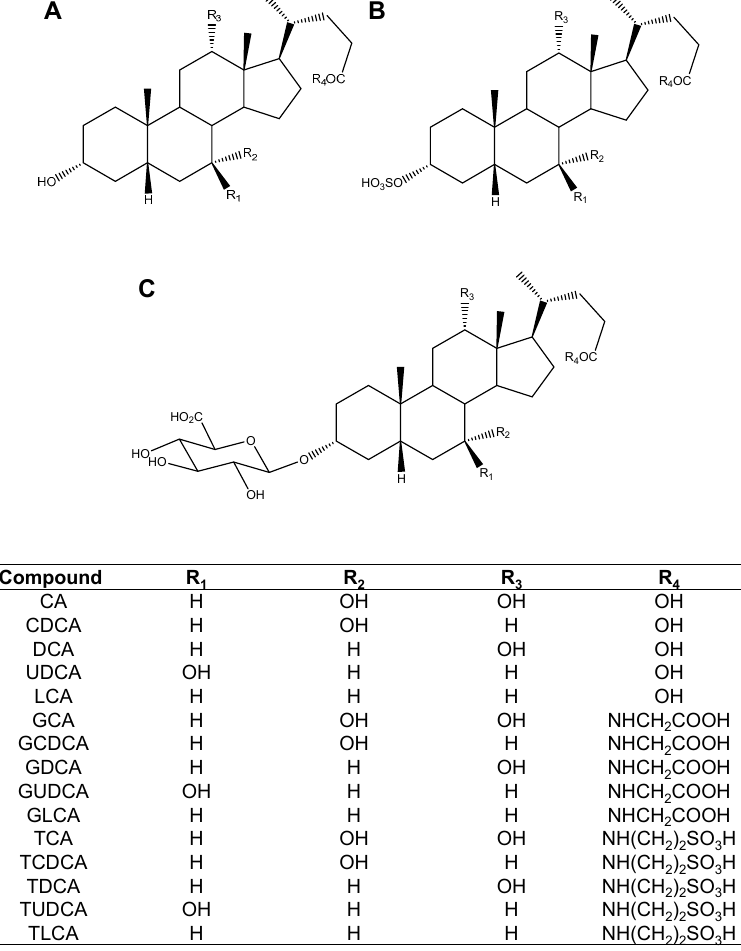
Figure 1. Chemical structures of ( A ) unconjugated, glycine-conjugated, and taurine-conjugated bile acids, ( B ) bile acid 3-sulfates, and ( C ) bile acid 3-glucuronides.